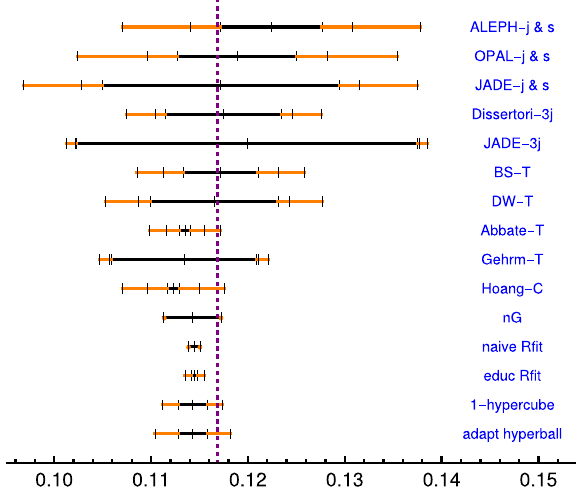
Fig. 13 Determinations of the strong coupling constant at M Z through e + e − annihilation, and the averages resulting from the different models considered. The intervals are given at 3 σ . See Fig. 12 for the legend